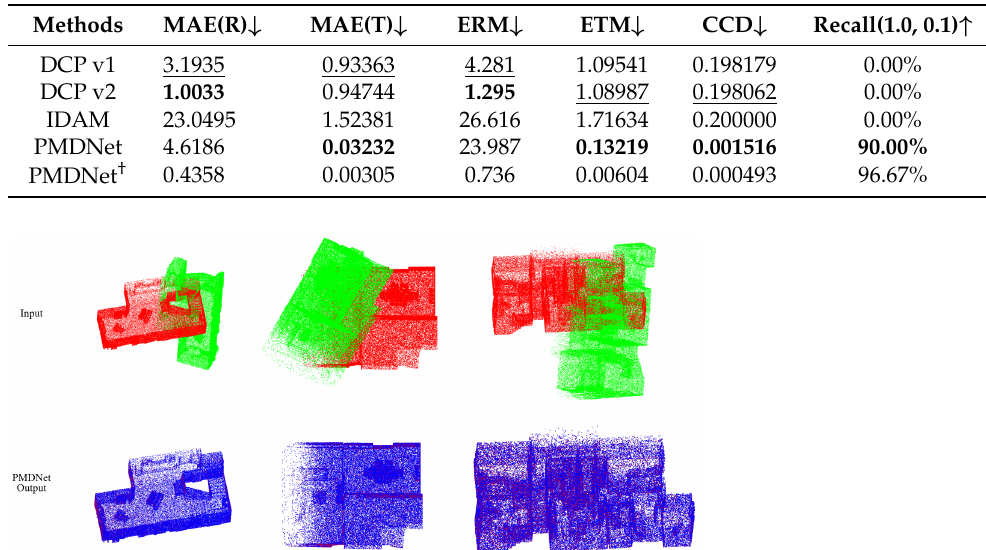
Figure 9. Qualitative results of the PMDNet on density-decreasing clean BIM data. src , ref , and pred clouds are colored in green, red, and blue, respectively.